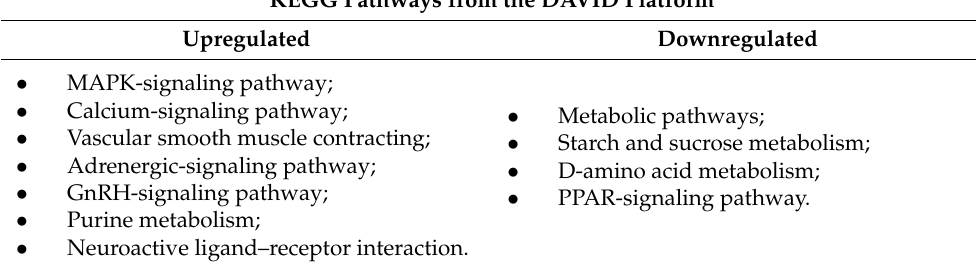
Table 3. Functional annotation chart based on gene set enrichment analysis with EASE score, a modified Fisher exact p -value ( p <